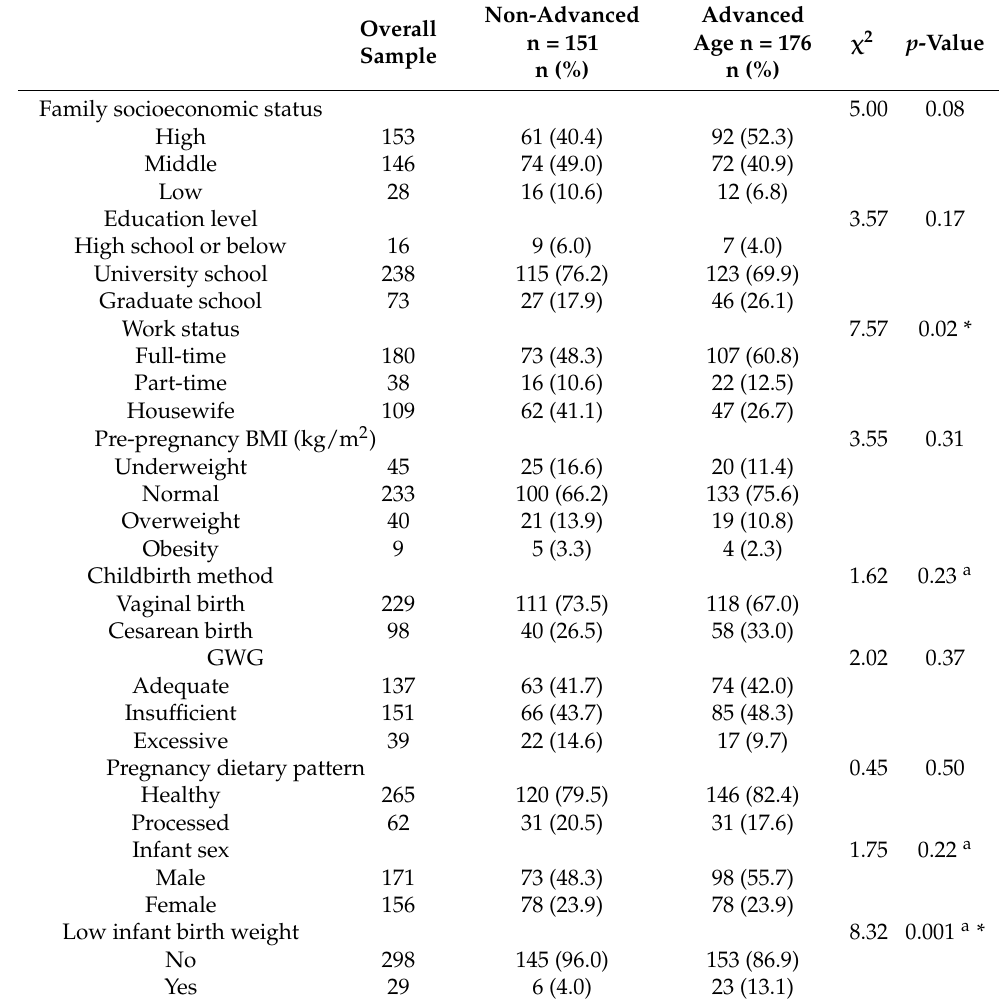
Table 2. Characteristics of the study participants (N =